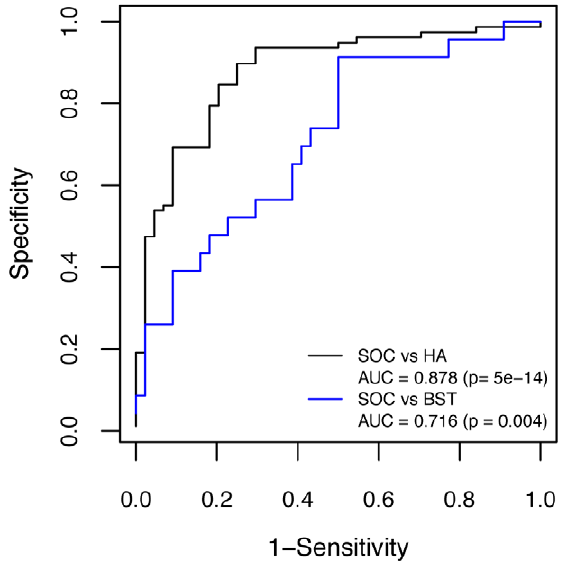
Figure 4. IGFBP1 ROC curves. SOC vs HA is shown in black and SOC vs BST in